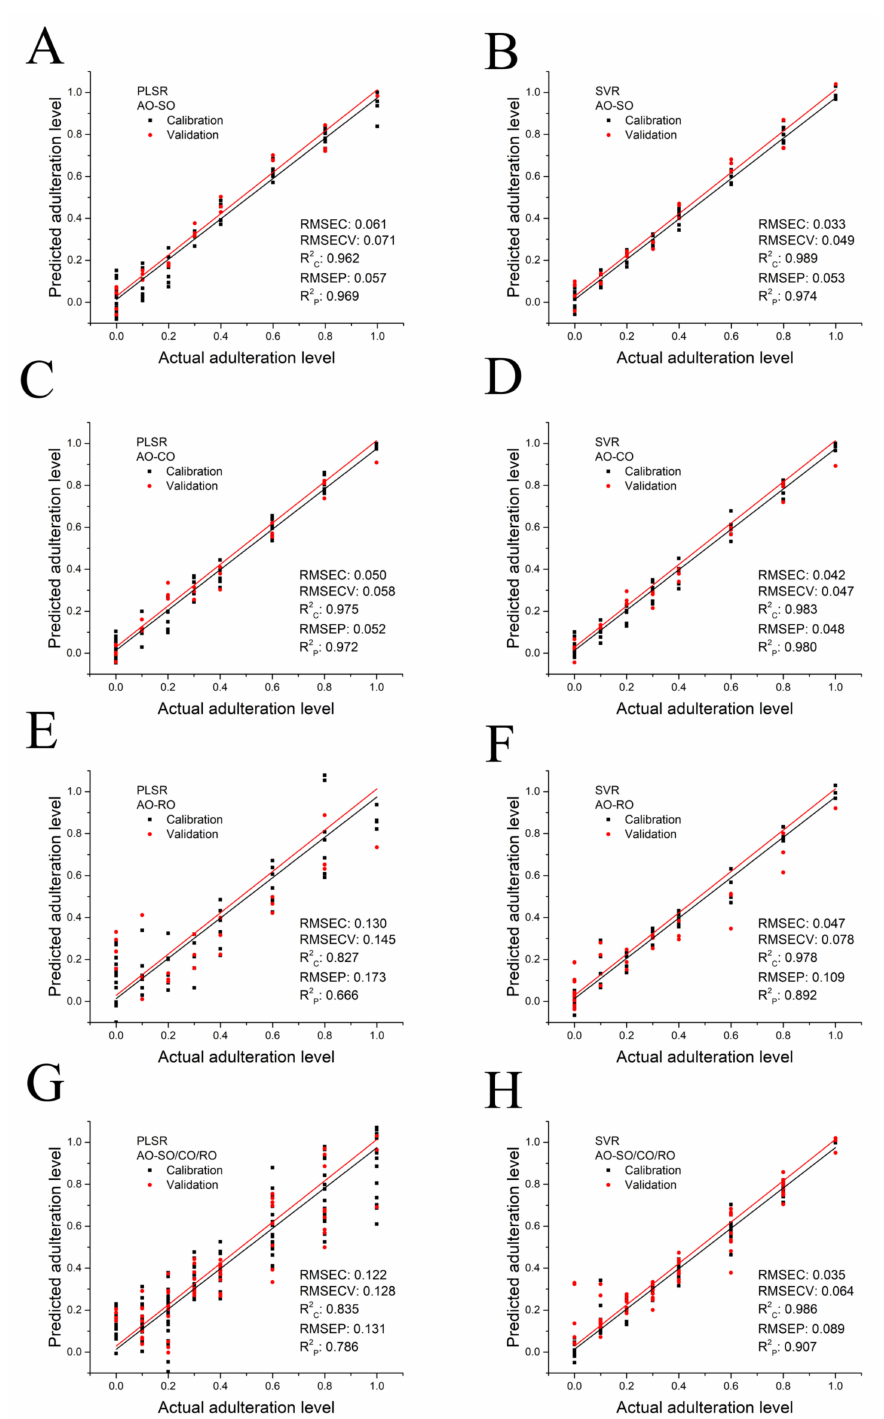
Figure 4. Prediction of adulteration level of AO adulterated by SO, CO or RO, as determined by the PLSR and SVR algorithm: AO-SO–AO adulterated with SO ( A , B ), AO-CO– AO adulterated with CO ( C , D ), AO-RO–AO adulterated with RO ( E , F ) and AO-SO/CO/RO–AO adulterated with SO, CO or RO randomly ( G , H